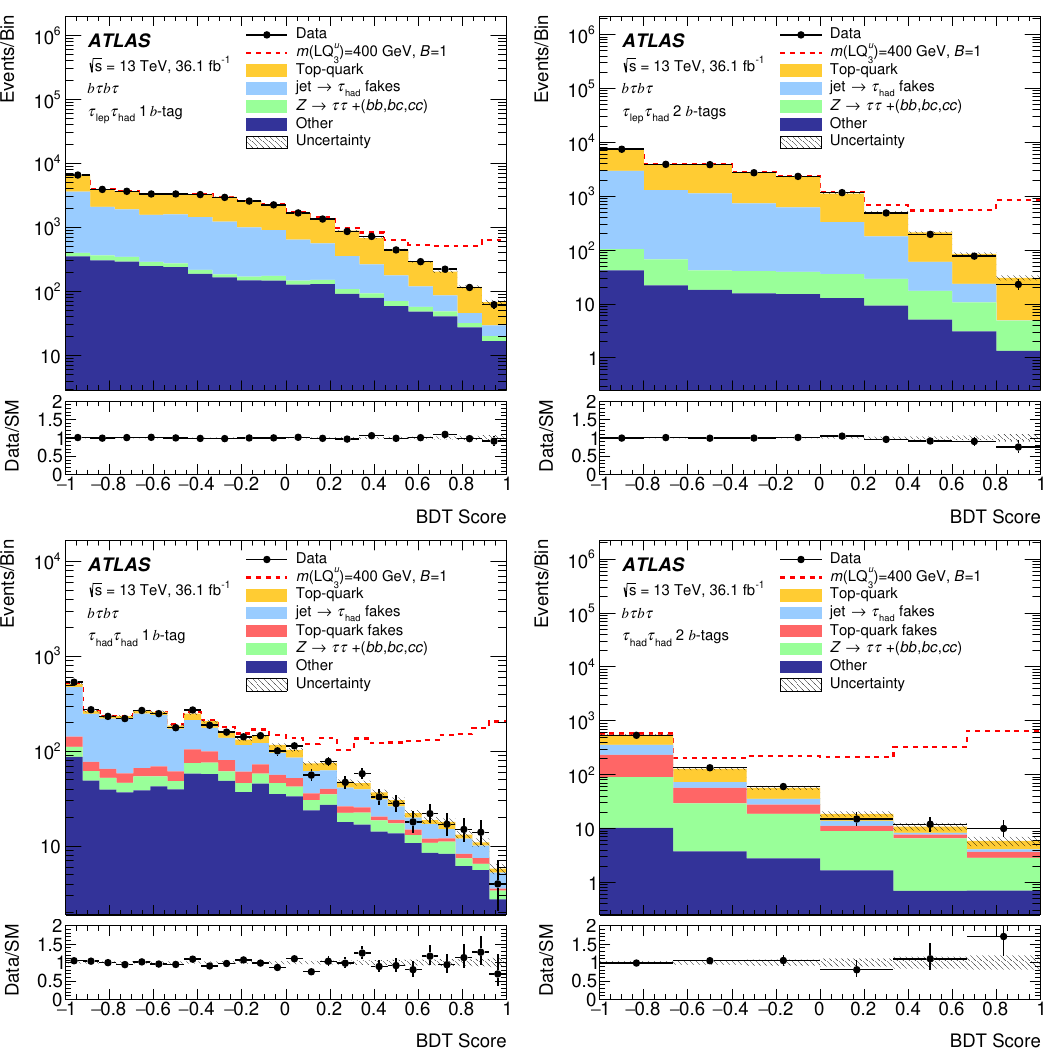
Figure 6 . BDT score distributions for (cid:28) ‘ (cid:28) had (top) and (cid:28) had (cid:28) had (bottom) channels in the 1-tag (left) and 2-tag (right) regions after performing the combined channel (cid:12)t. The stacked histograms show the various SM background contributions, which are normalized to the expected cross-section. The hatched band indicates the total statistical and systematic uncertainty in the SM background. The error bars on the black data points represent the statistical uncertainty in the data yields. The dashed histogram shows the expected additional yields from a leptoquark signal model for a up-type leptoquark sample with a mass of 400 GeV ( B = 1) added on top of the SM prediction. The ratio of the data to the sum of the backgrounds is shown in the lower panel.